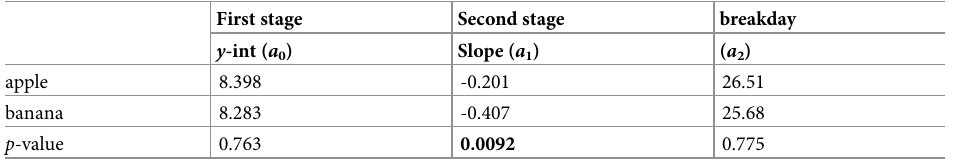
Table 1. Parameter estimates from the two-stage linear model fitted to p the banana and apple